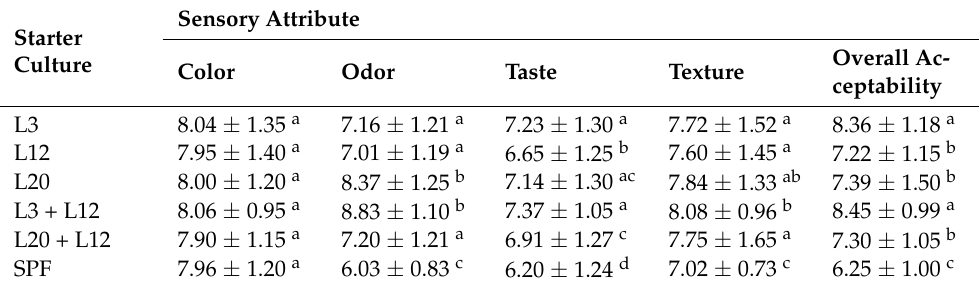
Values represent means of three independent experiments, ± : standard deviation. Values in the same column with different superscript letters are significantly different from each other ( p < 0.05). L3: Lactococcus lactis ; L12: Lactobacillus delbrueckii ; L20: Leuconostoc mesenteroides ; L3 + L20: combined starter of Lact. lactis and Leuc. mesenteroides ; L20 + L12: combined starter of Leuc. mesenteroides and Lact. lactis ; SPF: spontaneous fermentation (without starter